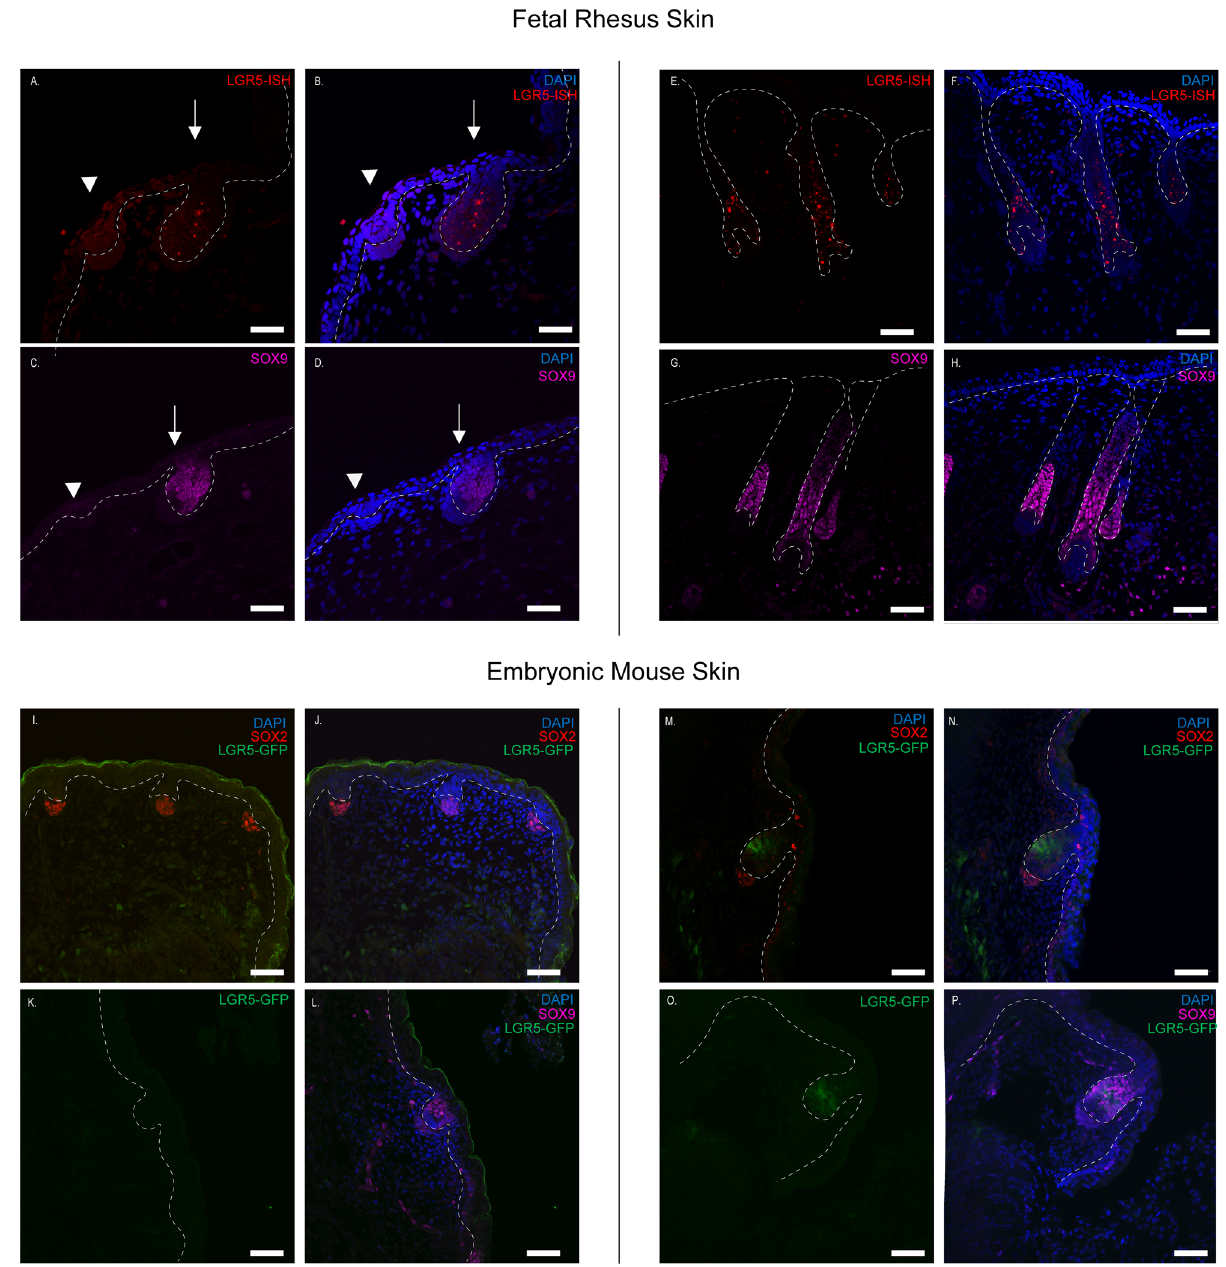
Figure 6. LGR5 expression in rhesus and mouse hair during follicle morphogenesis. In rhesus LGR5 mRNA was detected using RNAscope (Red- LGR5-ISH ) as detailed in the materials and methods section. Dashed lines delineate the border between the developing dermis and epidermis. ( A – D ) Gestational day 60 and ( E – H ) gestational day 90 samples. ( A , B ) LGR5 mRNA (Red- LGR5-ISH) is present, but expressed at a low level in the placode (arrow head), while it is robustly expressed in the hair peg (arrow). Similarly, SOX9 protein expression is absent in the placode (arrowhead), but present in the hair peg (arrow). The cells directly adjacent to the dermal papillae, with a perpendicular orientation to the basement membrane, are SOX9 negative. ( E – H ) Gestational day 90. As in pigs, the rhesus monkey hair follicles also develop in a triple pattern. ( E , F ) LGR5 mRNA expression and ( G , H ) SOX9 protein expression is maintained throughout the lower hair follicle. ( I – P ) Day E15.5 hair follicle development in mouse tail ( I – L ) and dorsal skin ( M – P ). LGR5 expression was localized using a transgenic LGR5-eGFP line and anti-GFP antibodies. Embryonic day 15.5 mouse showing the placode ( I – L ) or peg stage ( M – P ) development, respectively. LGR5-GFP is undetectable or absent at the placode stage, although SOX2 (dermal papillae) and SOX9 (placode) are present. In the hair peg stage, LGR5-GFP is present, but limited to the mid-peg region and not in contact with the dermal papillae, similar to the pattern of SOX9 expression. Images are representative examples of at least three biological replicates per stage per species. Scale bars represents 50